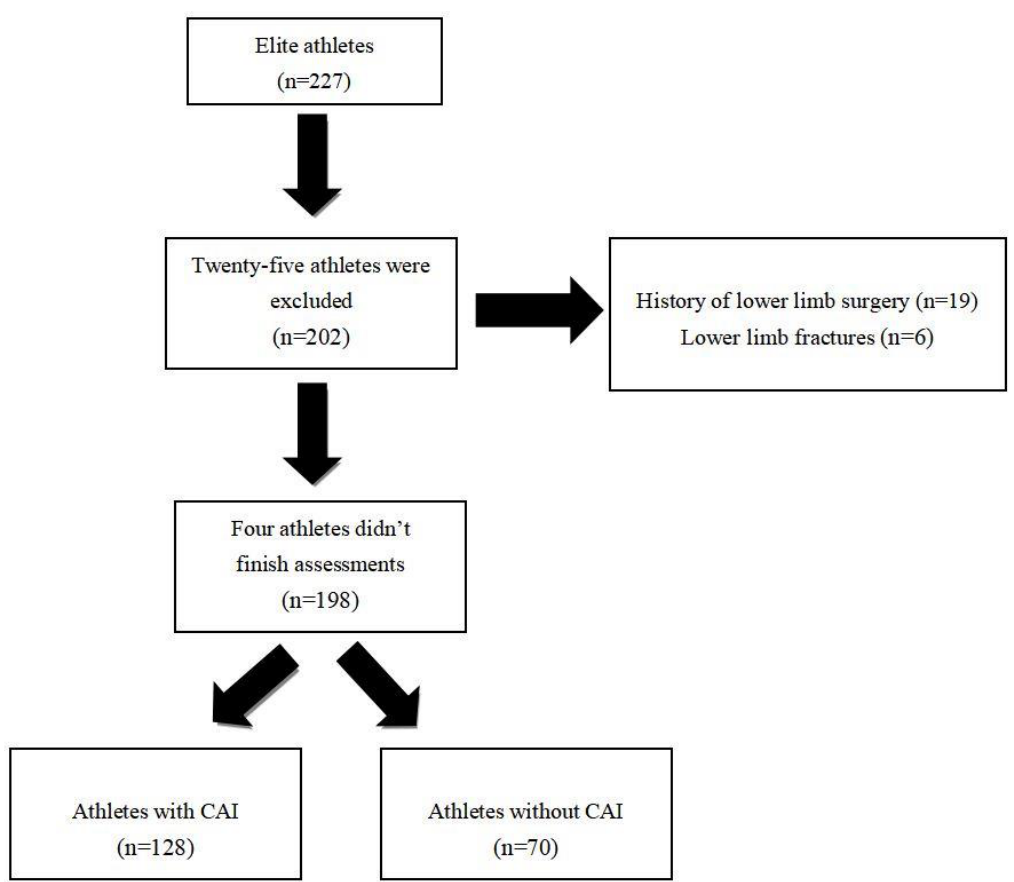
Figure 1. Participants inclusion and exclusion process.